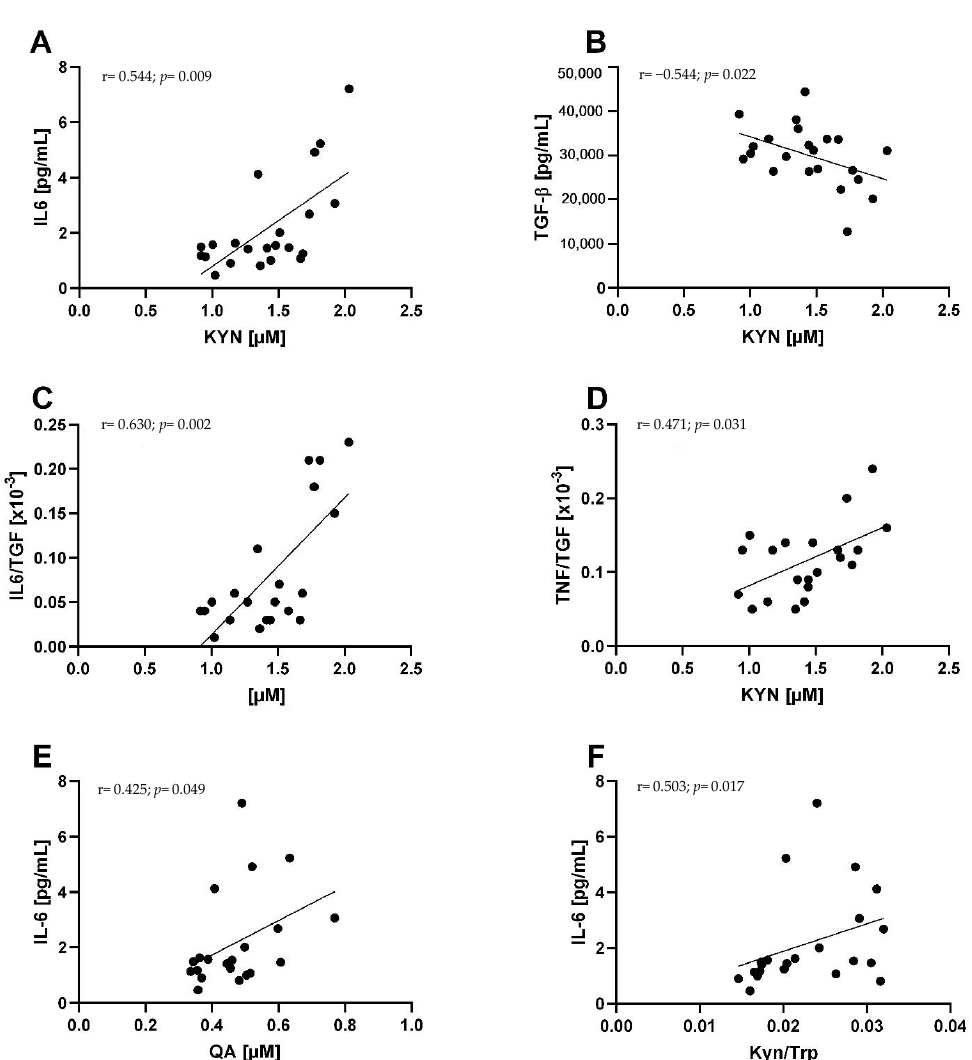
Figure 1. Baseline associations between the KYN pathway and inflammatory markers. Correlations were calculated according to Spearman’s coefficients. Graphs show the correlations of KYN with IL-6 ( A ), TGF- β ( B ), as well as the ratios of IL-6/TGF- β ( C ) and TNF- α /TGF- β ( D ). Furthermore, the correlations of IL-6 with QA ( E ) and the KYN/TRP-ratio ( F ) is shown. Correlation coefficient and p -values are provided in each